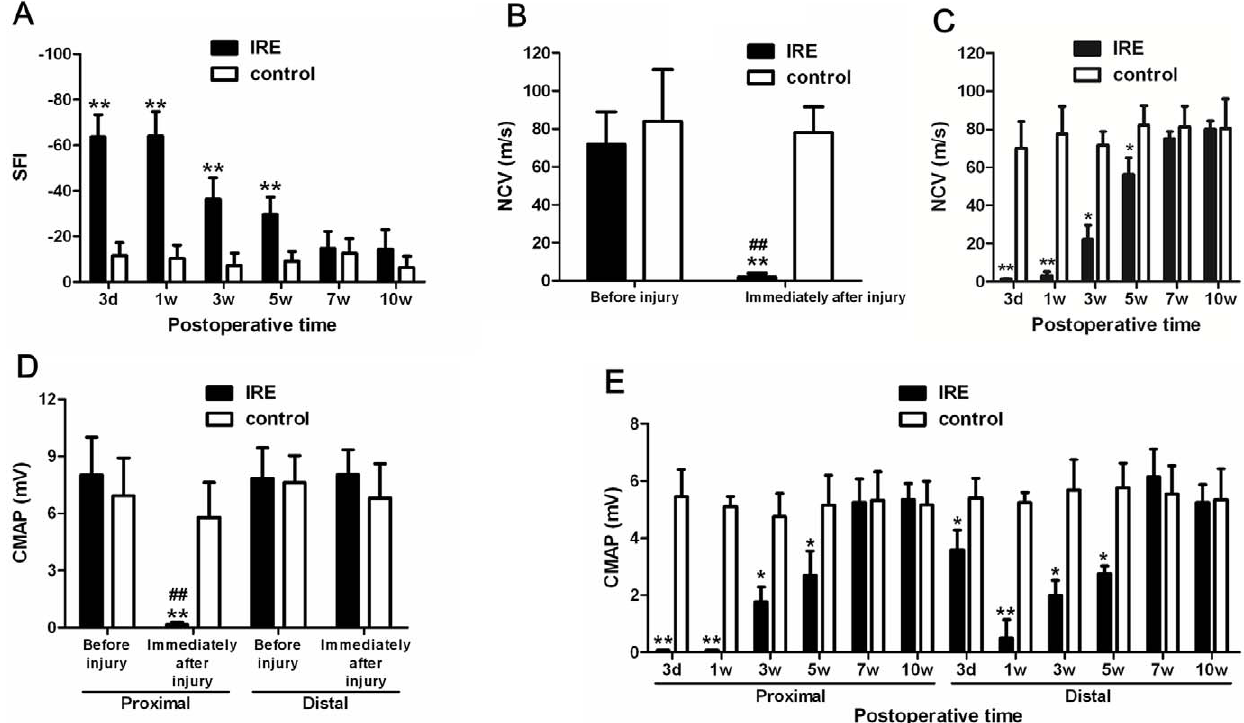
Figure 1. Functional recovery after sciatic nerve injury. (a) Measurements made from walking track prints were then submitted to SFI. (b) NCV evaluation before and immediately after sciatic nerve injury. (c) NCV evaluation at 3 days, 1 week, 3, 5, 7, and 10 weeks after sciatic nerve injury. (d) CMAP evaluation before and immediately after sciatic nerve injury. (e) CMAP evaluation at 3 days, 1 week, 3, 5, 7, and 10 weeks after sciatic nerve injury. * P , 0.05, ** P , 0.01 versus control group.